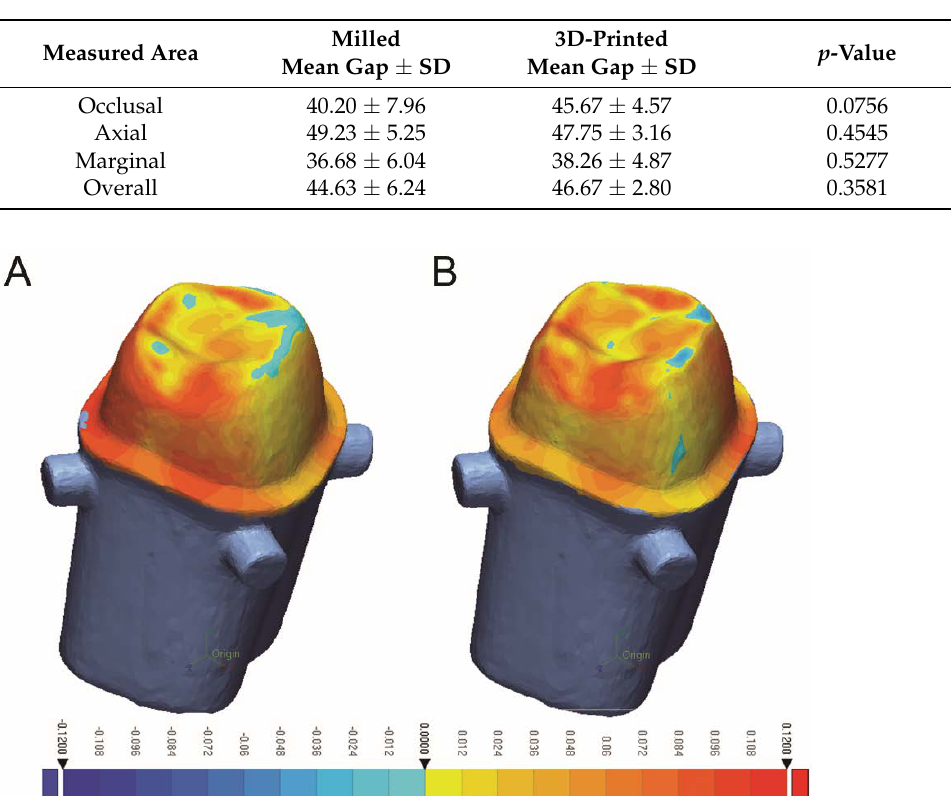
Figure 2. Colorimetric map of fit analysis for ( A ) Milled crowns, ( B ) 3D-printed crowns.